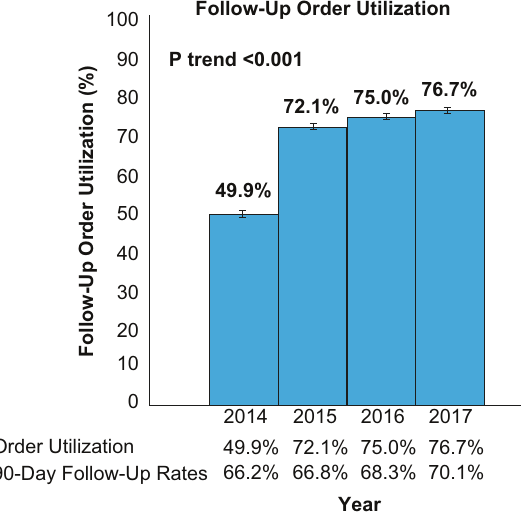
Fig. 1 Follow-up order utilization. Within the fi rst year of implementation, 49.9% of discharges utilized the follow-up order showing a strong provider adoption. Our providers continued to use it in an increasing fashion in the subsequent years, demonstrating a sustainable process. ( P trend 0.001). In addition, the rate of order utilization steadily increased from 49.9% in 2014 to 76.7% in 2017.